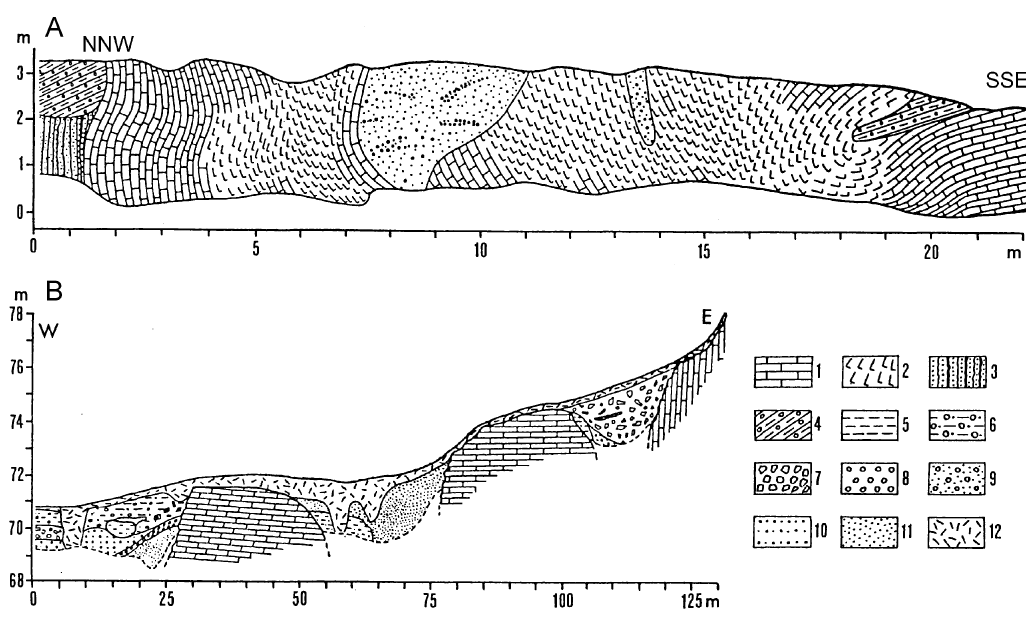
Fig. 7. Vertical sections of the exposures at Tornim(cid:228)gi ( A ) and Pargim(cid:228)gi ( B ) (from Miidel et al. 1969): 1, limestone; 2, shattered limestone; 3, sandstone with graptolite argillite interbeds; 4, till; 5, green clayey till; 6, brown sandy till; 7, grey carbonaceous till; 8, pebbles; 9, glaciofluvial gravel and pebbles; 10, sandy gravel; 11, cross-bedded sand; 12, soil. For location of exposures 2 (at Tornim(cid:228)gi) and 9 (at Pargim(cid:228)gi) see Fig.